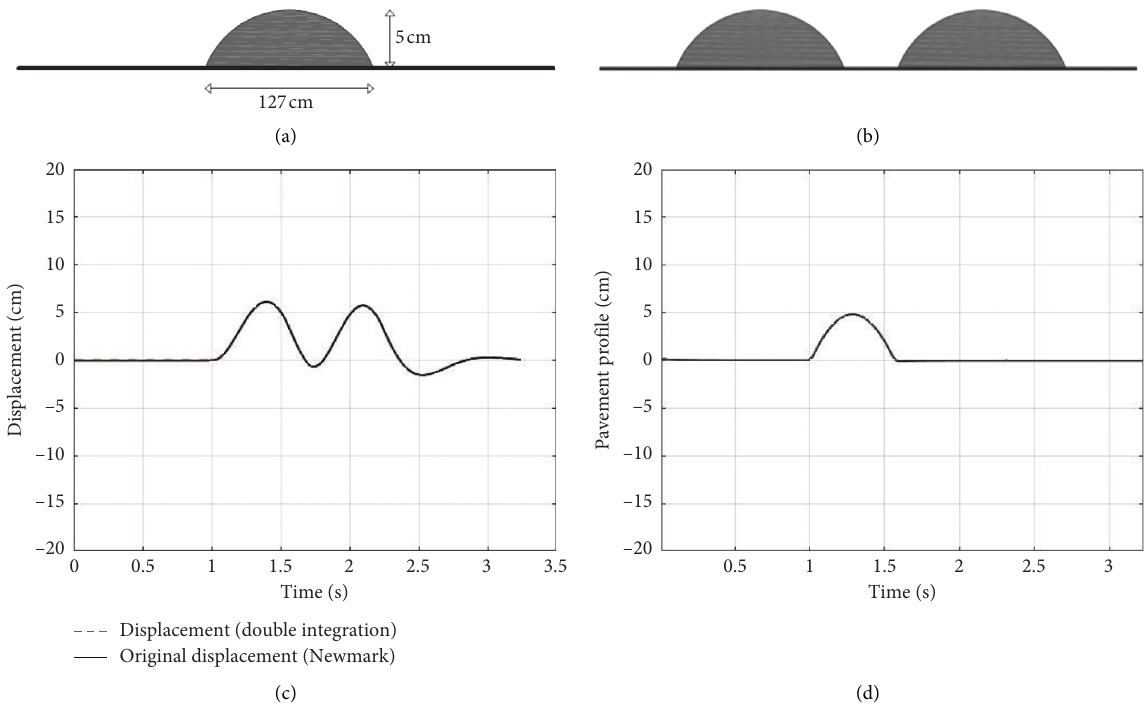
Figure 3: Numerical pavement profile estimation (no noise included). (a) The speedbump geometry. (b) The input pavement profile. (c) Displacement response (echo and vehicle dynamics effects included). (d) Pavement profile estimation (deechoed and vehicle dynamics removed).